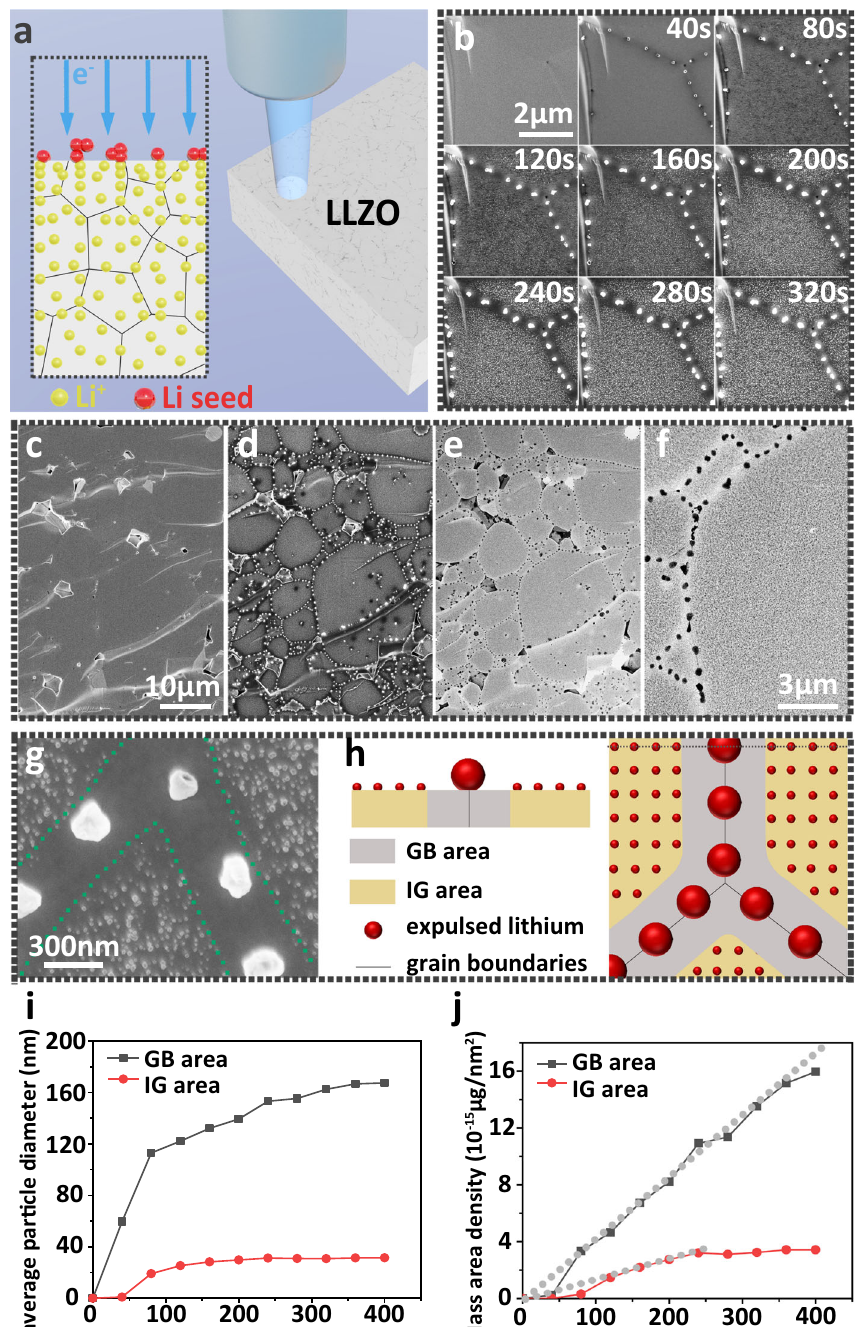
Fig. 4 | Electron beam irradiation of LLZO surfaces. a Schematic diagram of electron injection causing a reduction of lithium ions in LLZO into lithium metal. b Morphological evolution of lithium particles on a LLZO cross-section with increasing duration under electron-beam irradiation. The surface includs grain boundaries and in-grain areas. c Initial LLZO cross-section morphology under electron-beam irradiation on a large scale. d Morphology changes after electron- beam irradiation for 400s. c and d are recorded by measuring in secondary electron detection mode. e Same area as in d , but electrons were collected with a